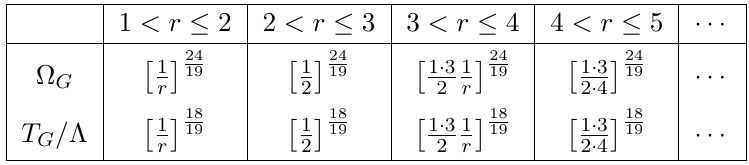
Table 5 . The explicit forms for (cid:10) G and T G = (cid:3) for the (cid:12)rst few ranges of r = R (cid:3). where eq. (2.11) was used. As examples, T S =(1612, 1276, 1031) GeV for r = 1 : 5 and (779, 617, 498) GeV for r = 4 for (cid:11) s ( m Z ) = (0 : 1175 ; 0 : 1183 ; 0 :